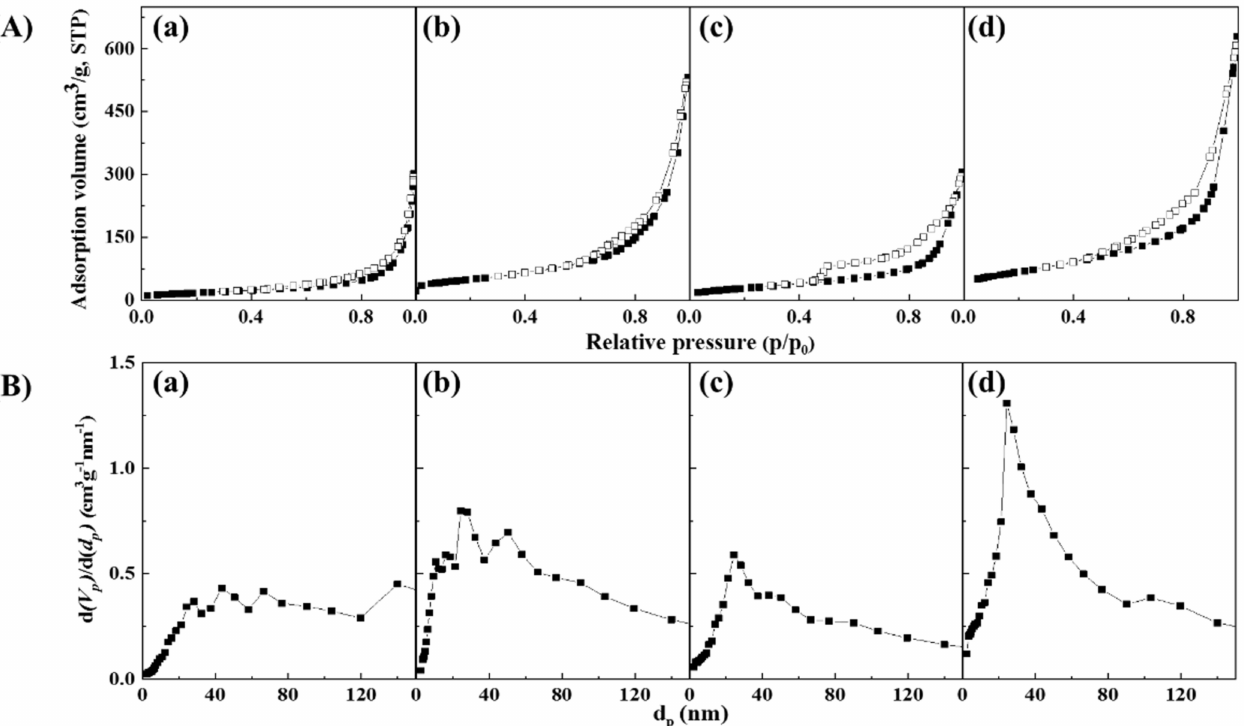
Figure 5. ( A ) N2 adsorption-desorption isotherms and corresponding ( B ) BJH pore size distribution plots for ( a ) AH-1, ( b ) AO-1, ( c ) AH-2, and ( d )